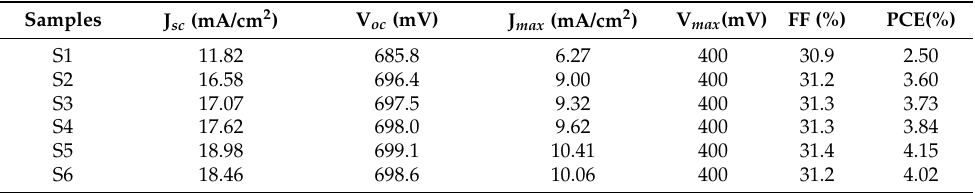
Figure 5. UV-Vis absorption spectra of the OSCs with and without Au@Ag NPs embedded into PEDOT:PSS at different ratios. 3.3. The Current Density–Voltage of OSCs with/without Embedding Au@Ag NPs into the Table 1. Electrical parameters of the